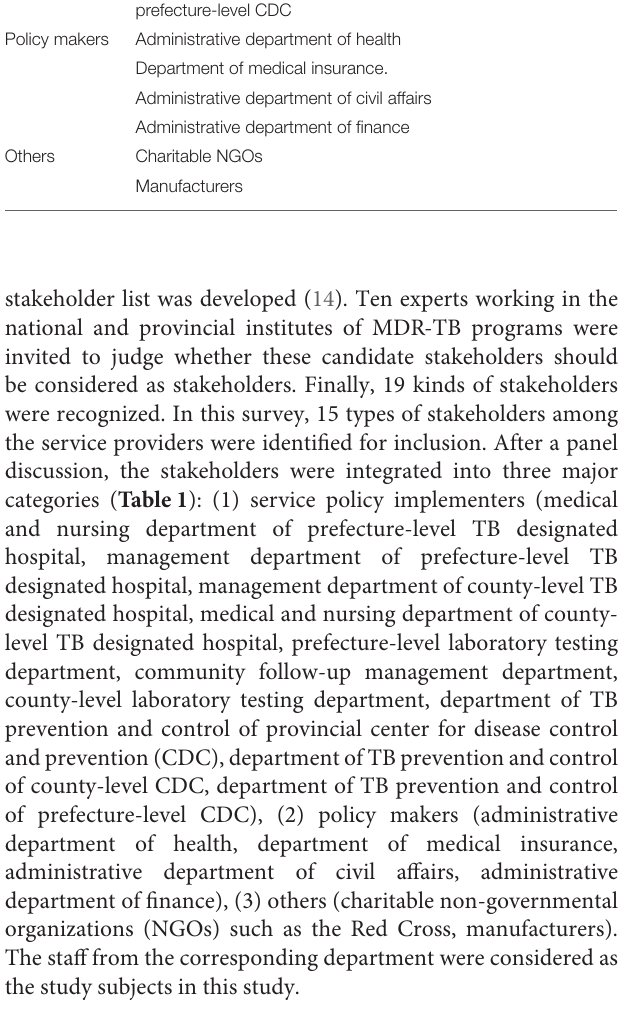
categories ( Table 1 ): (1) service policy implementers